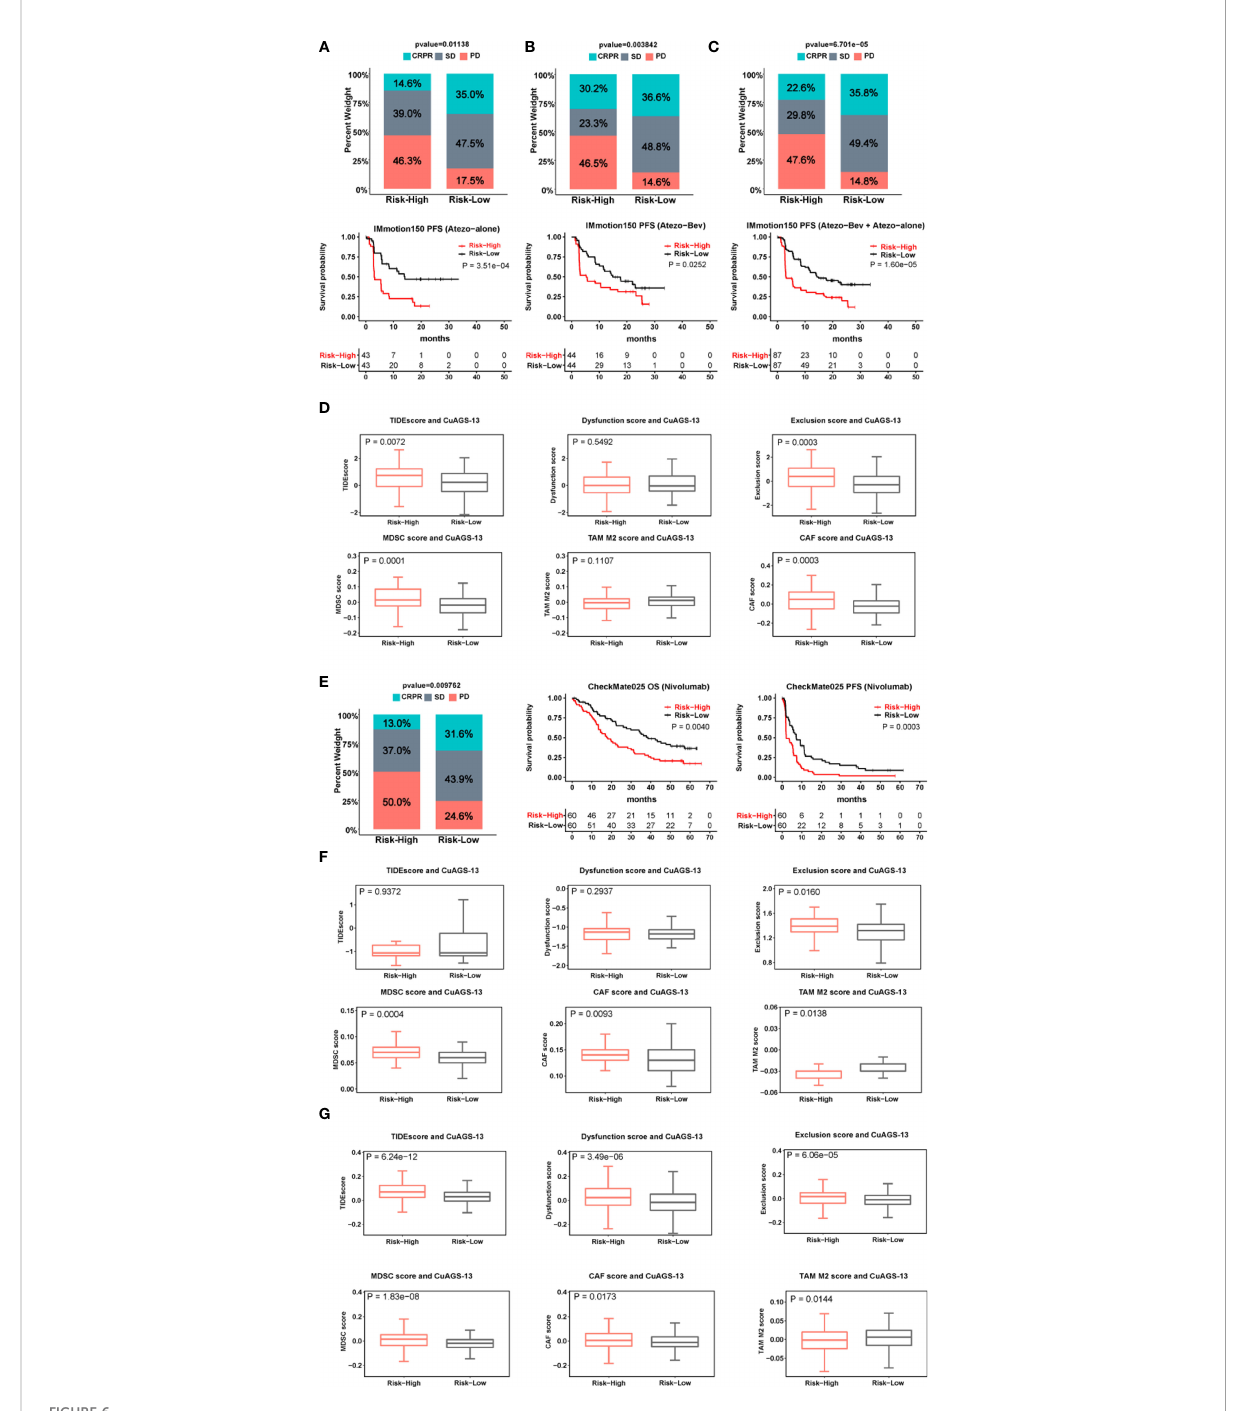
FIGURE 6 The CuAGS-13 score prediction of patient response to immune checkpoint inhibitors (ICIs) and combination with Bevacizumab in ccRCC. (A – C) The CuAGS-13 score prediction of patient response to Atezolizumab alone or Atezolizumab plus Bevacizumab in IMmotion150 trial. Differences in response rates and PFS between the CuAGS-13 high- and low-risk group patients treated with Atezolizumab alone (A) , Atezolizumab plus Bevacizumab (B) and all together (C) . (D) TIDE score analyses showing differences between the CuAGS-13 high- and low-risk group patients in IMmotion150 trial. (E) Differences in response rates and survival (OS and PFS) between the CuAGS-13 high- and low-risk group patients treated with Nivolumab in CheMate025 trial. (F) TIDE score analyses showing differences between the CuAGS-13 high- and low-risk group patients in CheMate025 trial. (G) TIDE score analyses showing differences between the CuAGS-13 high- and low-risk group patients in the TCGA ccRCC